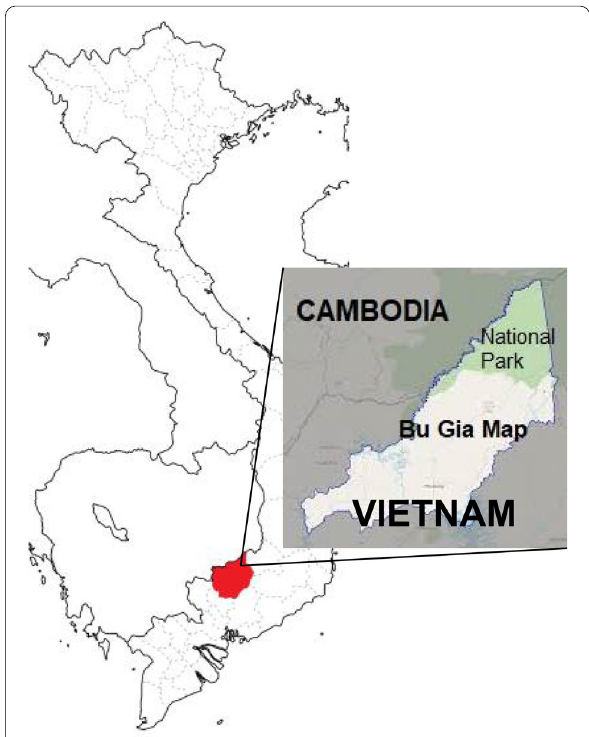
Fig. 1 Geographical map of Bu Gia Map commune, Binh Phuoc Province as the study